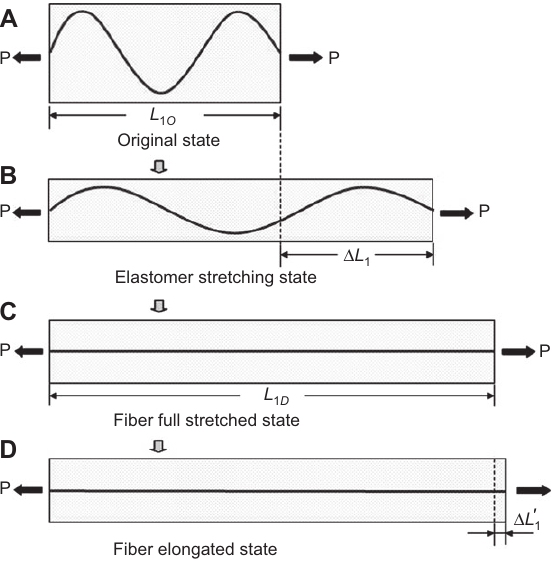
Figure 1 Schematic of the FRE material. Figure 2 Schematic illustration of the design